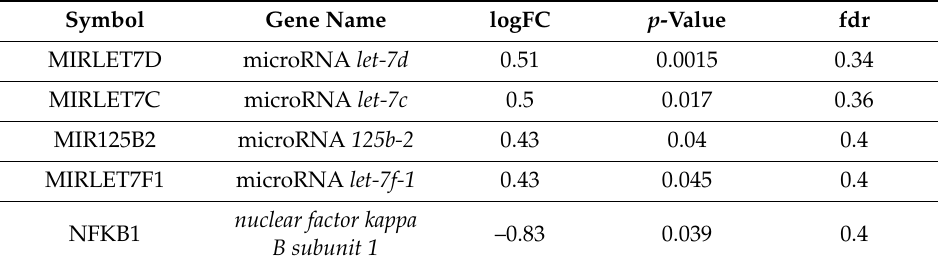
Table 1. A subset of di ff erentially expressed genes from microarray analysis, relevant to this study. Symbol